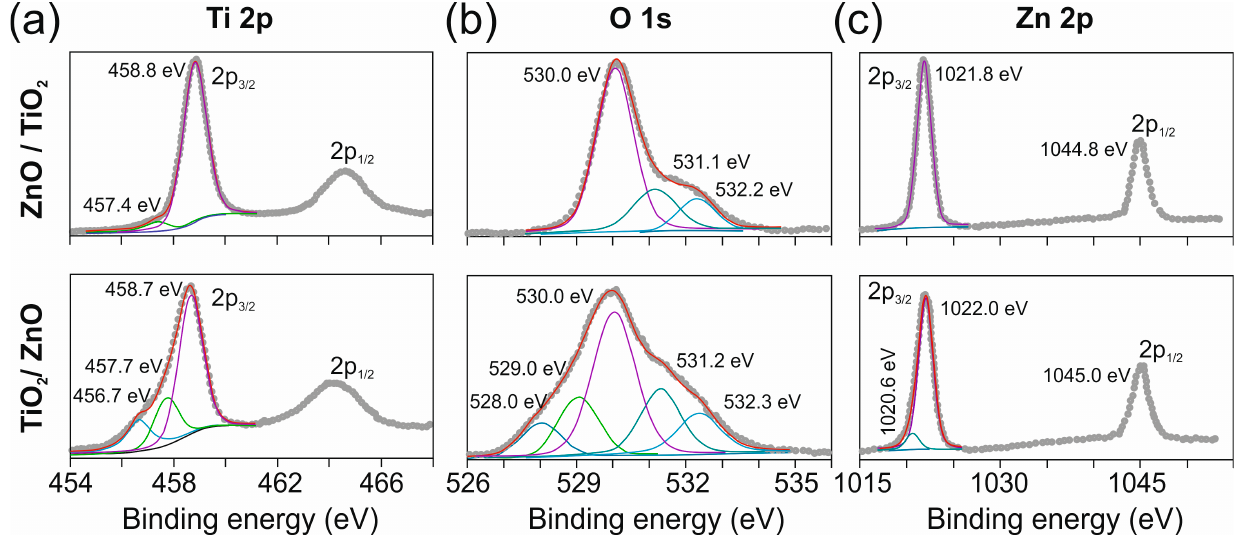
Figure 4. Ti 2p ( a ), O 1s ( b ), and Zn 2p ( c ) XPS spectra of hybrid materials: ZnO/TiO 2 (top row) and TiO 2 /ZnO (bottom row). Pink, green, and light blue fitting peaks in ( a ) are related to Ti 4+ , Ti 3+ , and Ti 2+ species, respectively. Pink, grey, light blue, light green, and dark blue fitting peaks in ( b ) are related to oxide ions from O 2 − ˗ Ti 4+ and O 2 − ˗ Zn 2+ bonds, oxygen vacancies, surface hydroxyl groups, O 2 − ˗ Ti 3+ , and O 2 − ˗ Ti 2+ bonds, respectively.